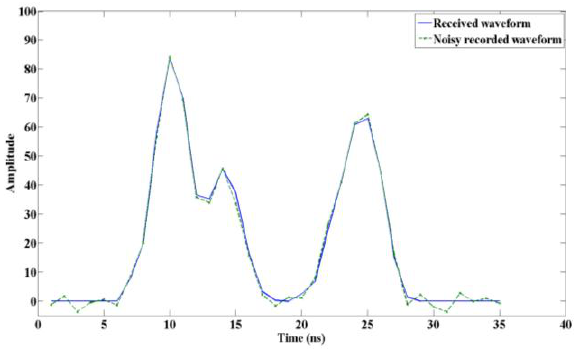
Figure 5. Received waveform and its noisy version (sample 2)